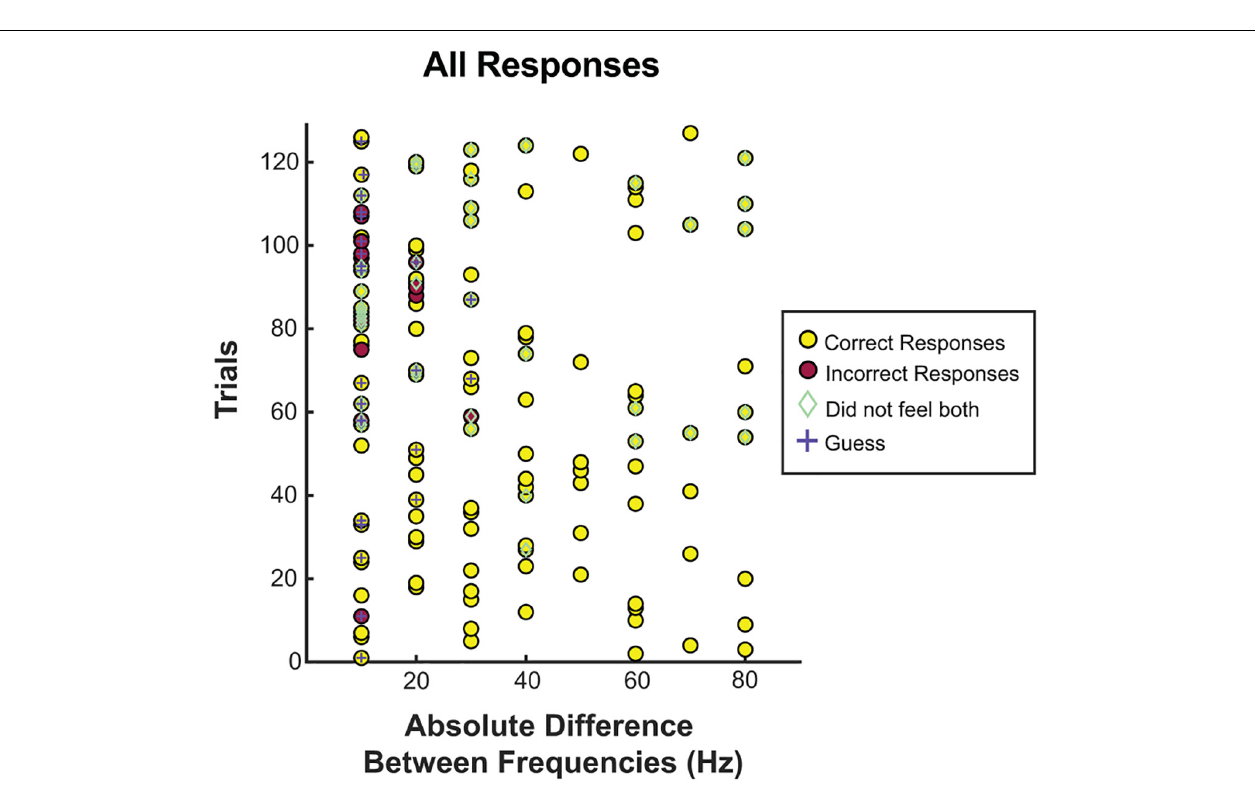
FIGURE 4 | Correct responses organized by absolute difference between two frequencies. All trials separated by the absolute difference in frequency. Correct and incorrect responses, guessing, and whether or not the patient felt both stimuli were recorded for each frequency difference. Most incorrect trials, guessing, and inability to feel both frequencies occurred at or below a difference of 20